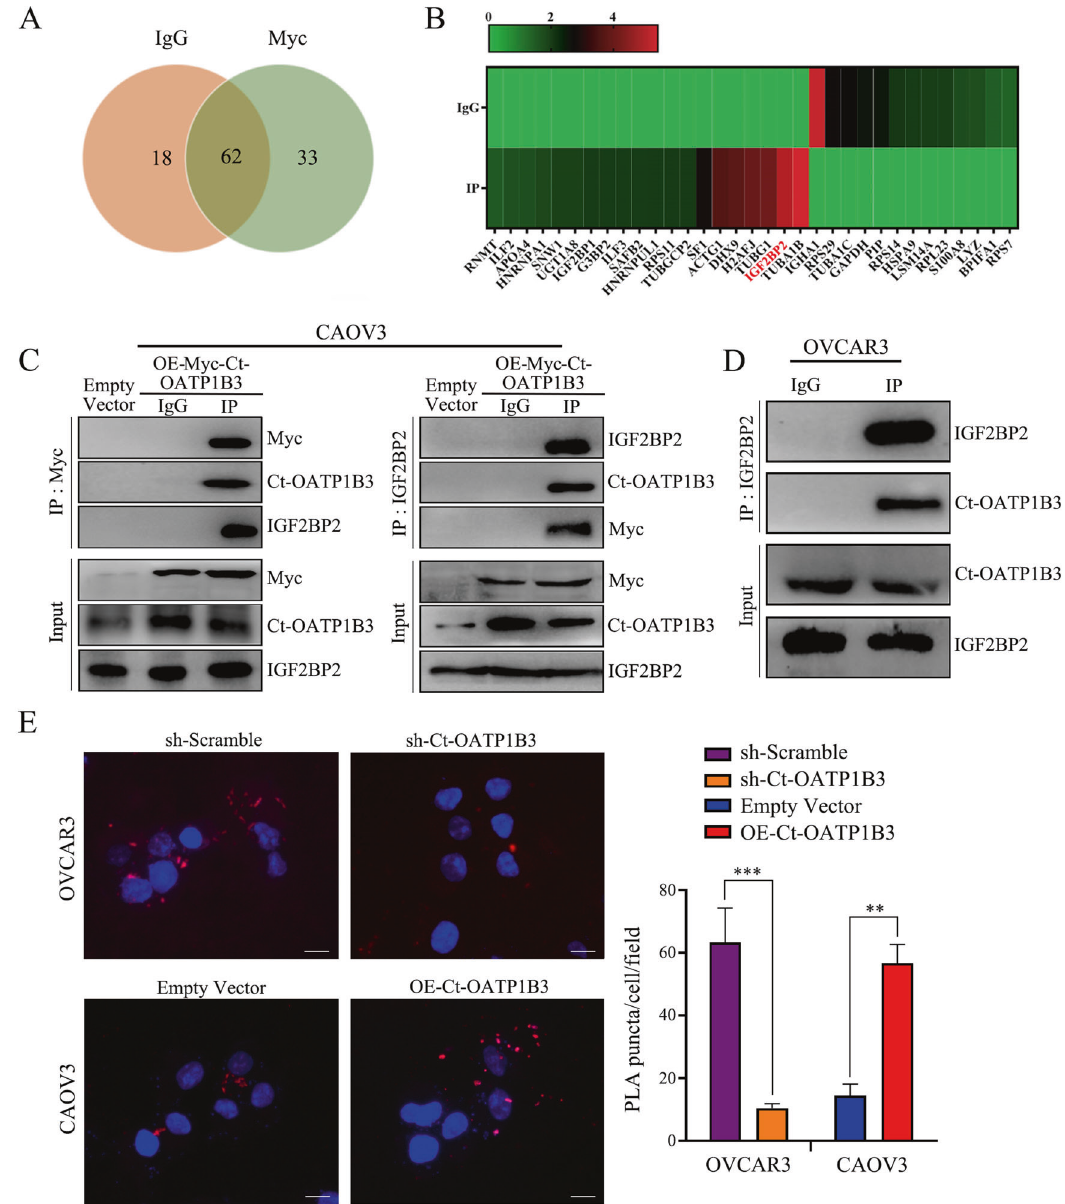
Fig. 3 Ct-OATP1B3 directly interacts with IGF2BP2 in HGSOC cells. A , B Venn diagrams and Heatmap showing the candidate proteins interacting with Ct-OATP1B3. C Reciprocal Co-IP analysis showing the Ct-OATP1B3-IGF2BP2 complex in myc-Ct-OATP1B3 overexpressing CAOV3 cells. D Co-IP analysis showing the endogenous Ct-OATP1B3-IGF2BP2 interaction in OVCAR3 cells. E In situ PLA reveals the direct physical interaction between Ct-OATP1B3 and IGF2BP2 in HGSOC cells. Scale bar, 20 μ m. ** P < 0.01, *** P <